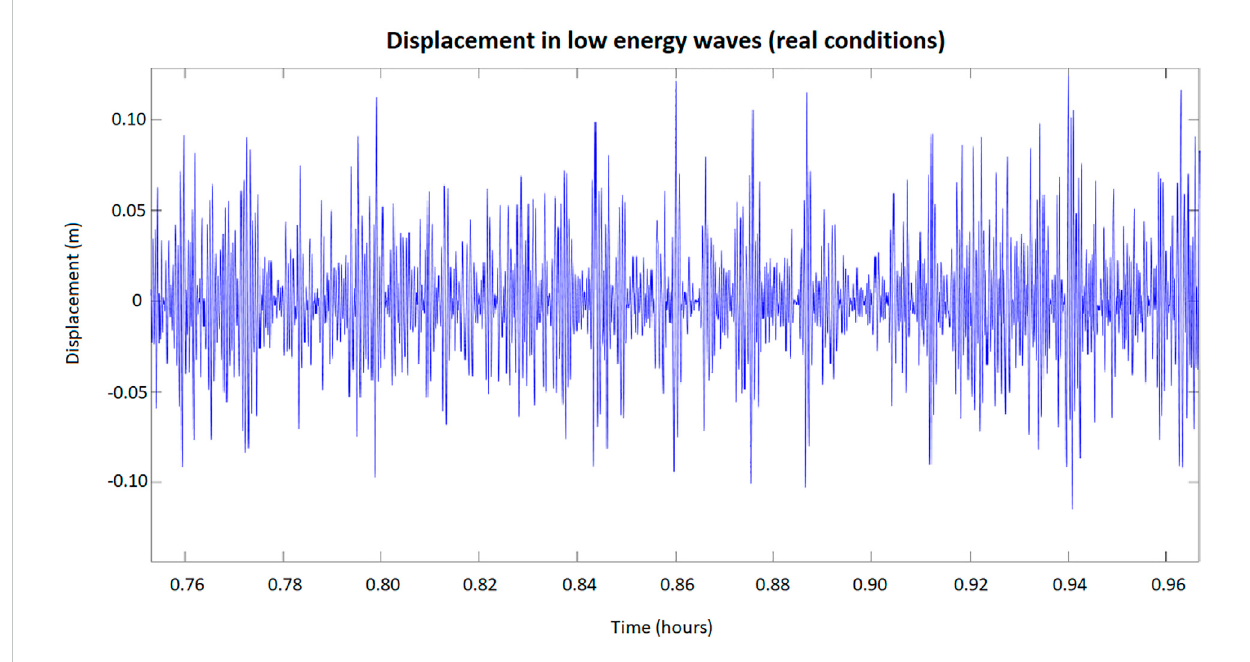
FIGURE 13 Displacement in low energy waves (real conditions).